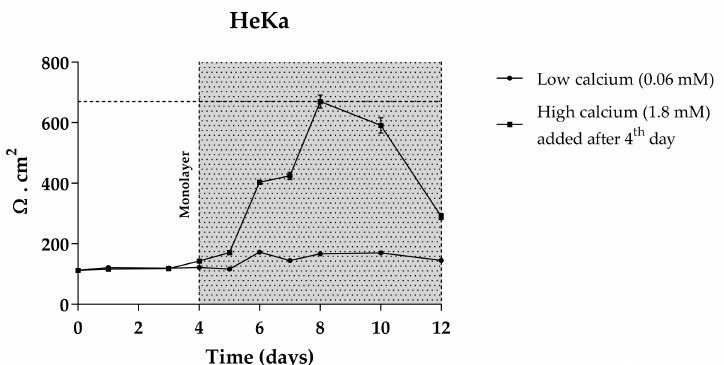
Figure 11. TEER measurements of HeKa cell monolayer during 12 days of culture. Cells were kept for 4 days in low calcium medium (0.06 mM) to allow monolayer formation. For differentiation, in the last 8 days medium was changed to high calcium (1.8 mM).